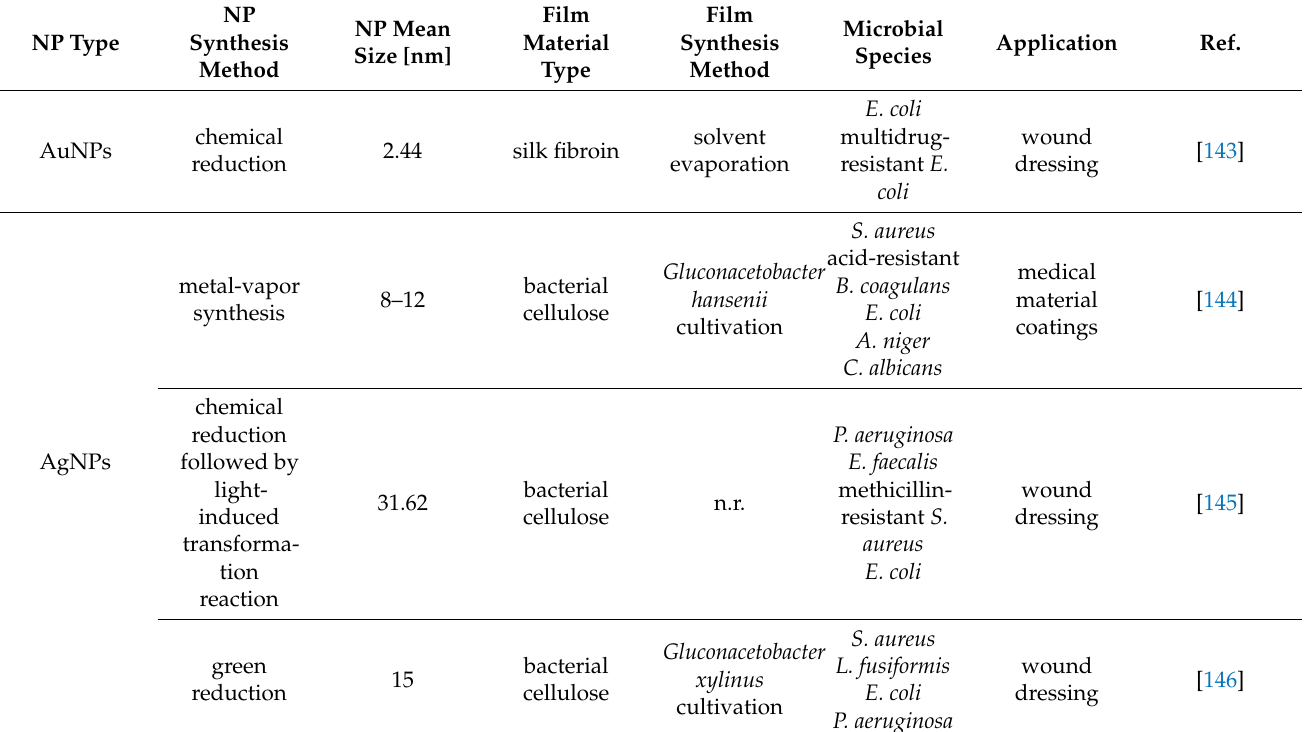
Table 2. Summary of the identified studies investigating the antimicrobial properties of inorganic NP-containing composite